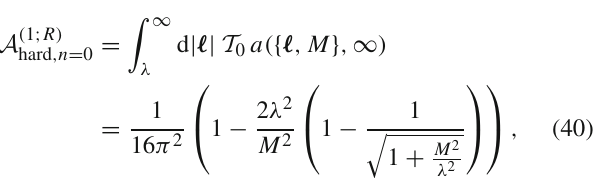
while in the hard